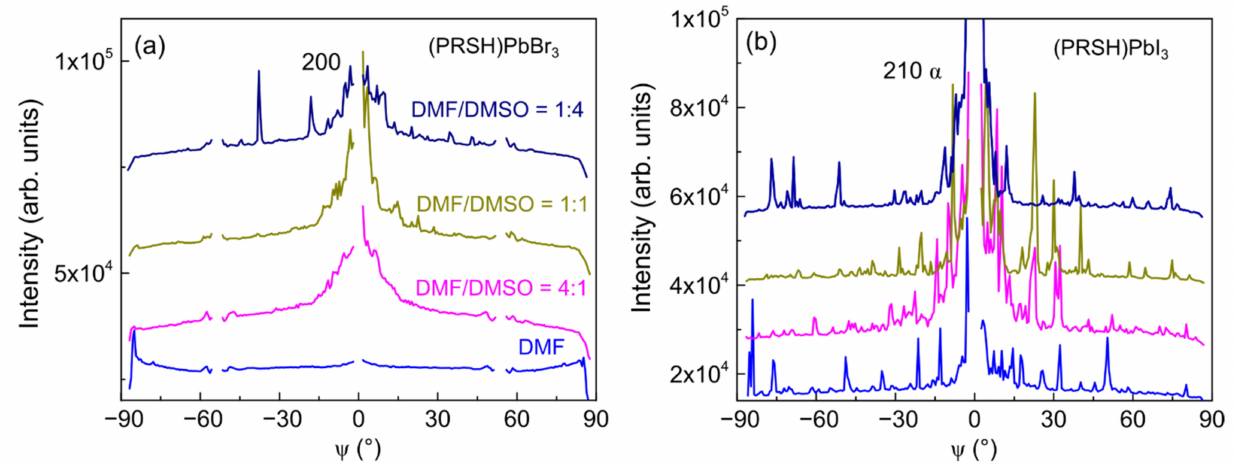
Figure 8. Azimuthal profiles for the dominant 200 reflection of (PRSH)PbBr 3 ( a ) and 210 α reflection of (PRSH)PbI 3 ( b